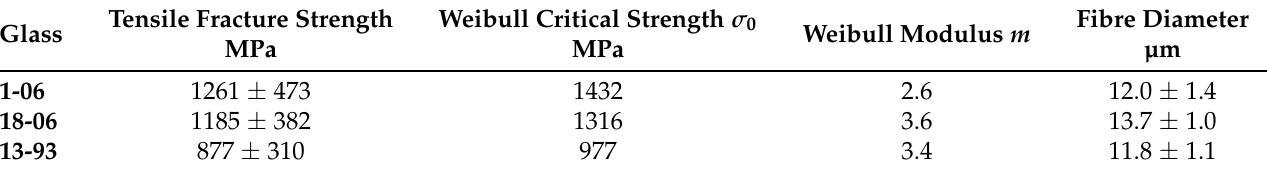
Table 7. Strength values of bioactive glasses with standard deviation.